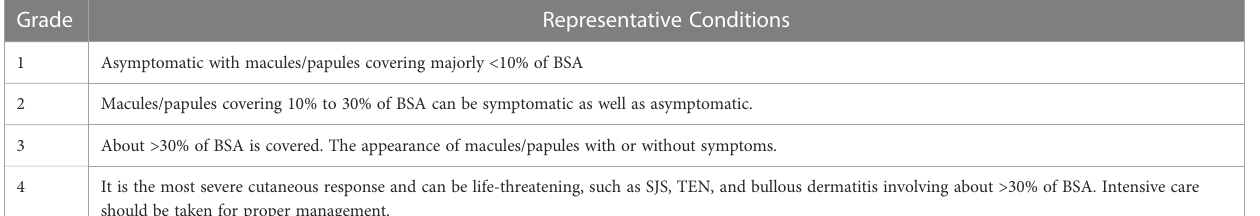
TABLE 2 Common Terminology Criteria for Adverse